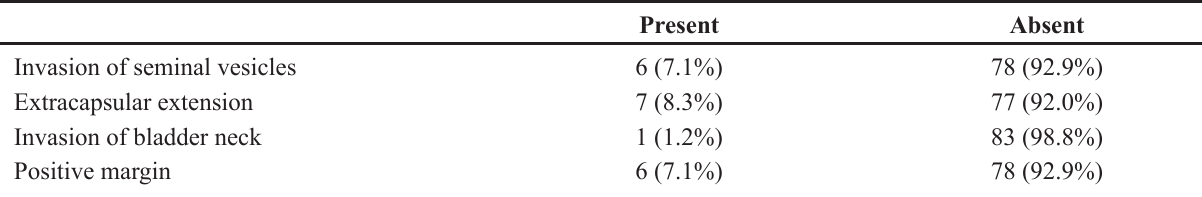
Table 5 – Pathological characteristics of surgical specimens of radical